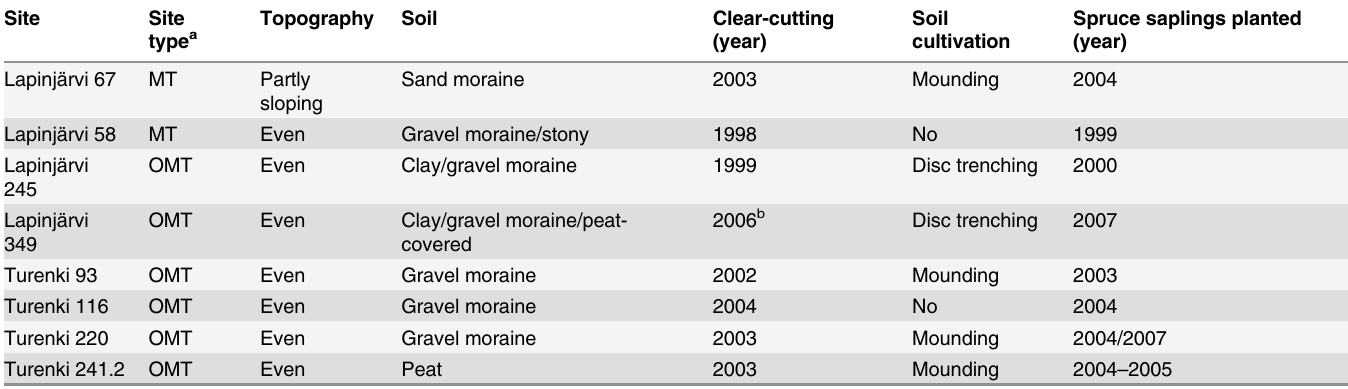
Table 3. Description of the Study Sites Included in the Field Experiment in Phase